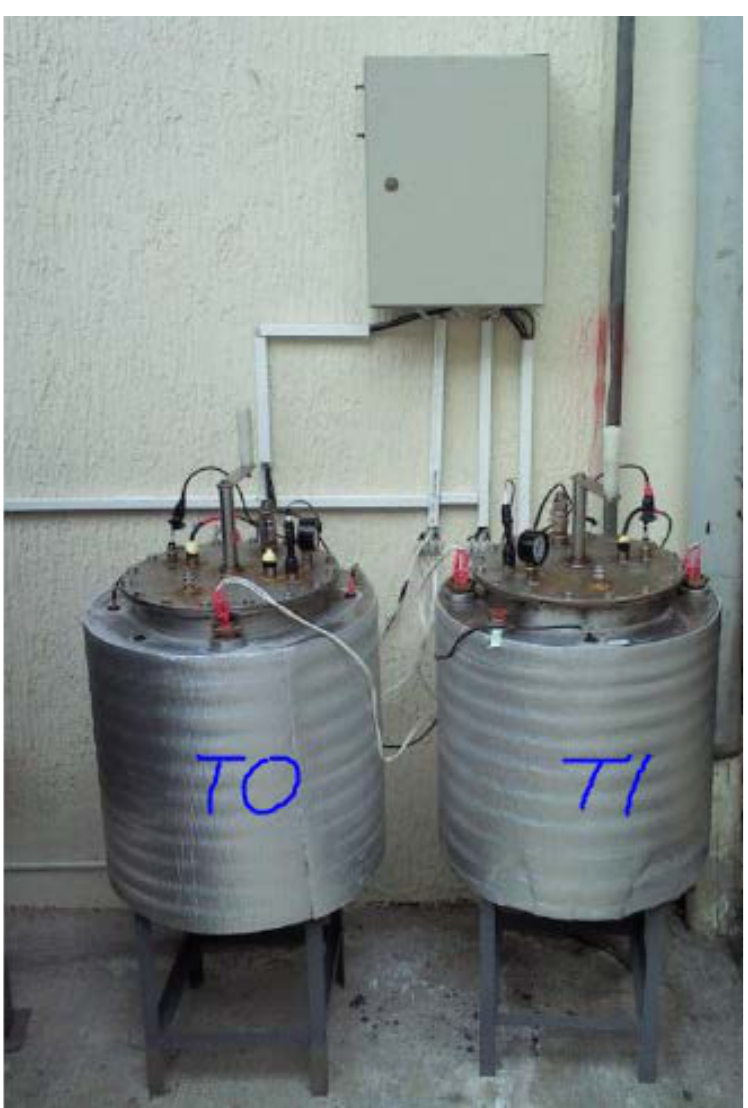
The tanks were isolated in the final installation as shown in Figure 7.